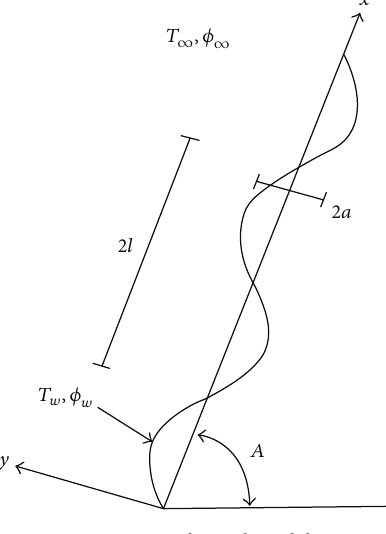
Figure 1: Physical